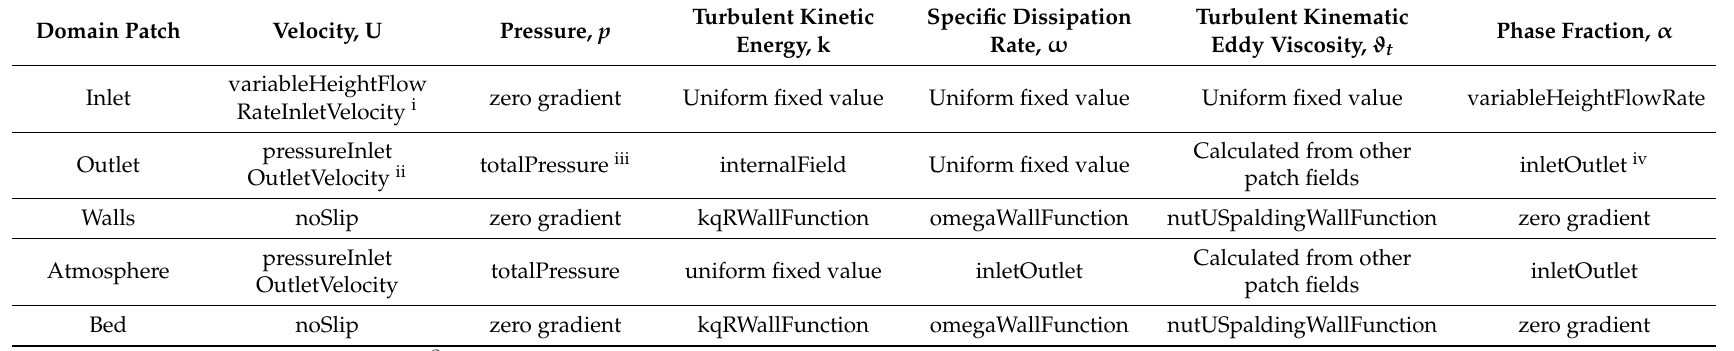
Table 4. Boundary conditions of the